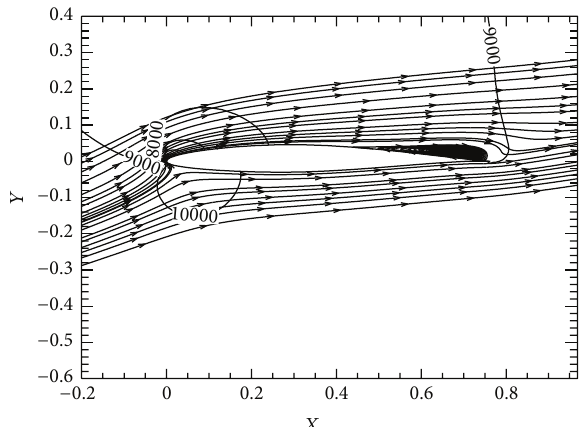
Figure 9: Pressure distribution and streamlines around the airfoil in the rain